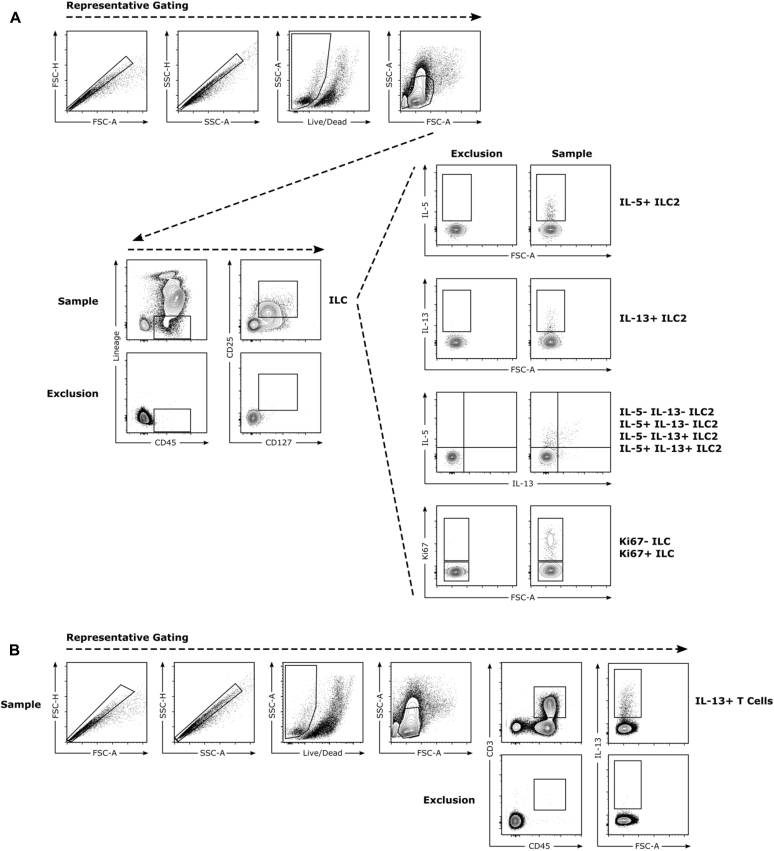
Flow cytometric gating strategies. A, ILCs were defined as viable Lin−CD45+CD25+CD127+ cells. ILC2s were defined as ILCs that were positive for either IL-5 or IL-13. B, T cells were defined as viable CD45+CD3+ cells. FSC, Forward scatter; SSC, side scatter.